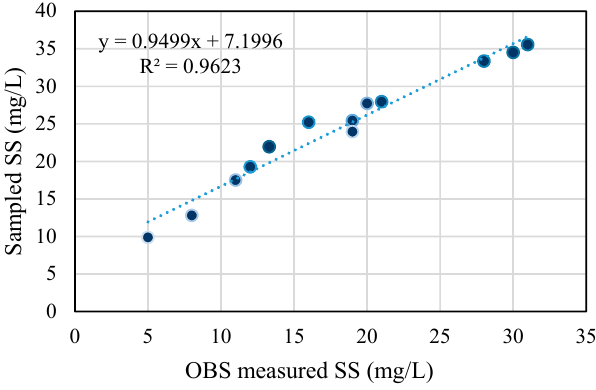
Figure 2. OBS calibration using the in situ mass obtained in water samples.